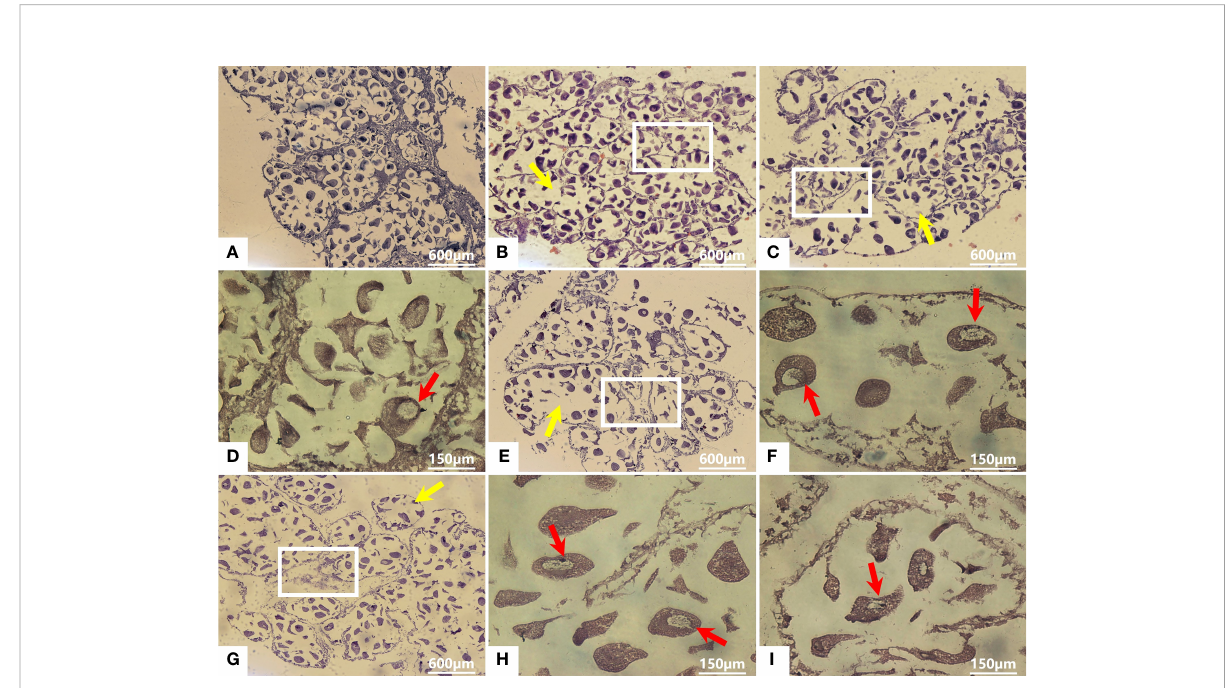
FIGURE 2 Histological sections of the ovary from M. meretrix that were subjected to Cd 2+ and no Cd 2+ treatments. Control group (A) ; Groups treated with 1.5 mg L − 1 Cd 2+ (B) , 3 mg L − 1 Cd 2+ (C, D) , 6.0 mg L − 1 Cd 2+ (E, F) , and 12 mg L − 1 Cd 2+ (G – I) . Yellow arrows indicate the irregularly distributed ovarian cells. Red arrows indicate nuclear chromatin condensation. Rectangles indicate the loss of gonadal tissue